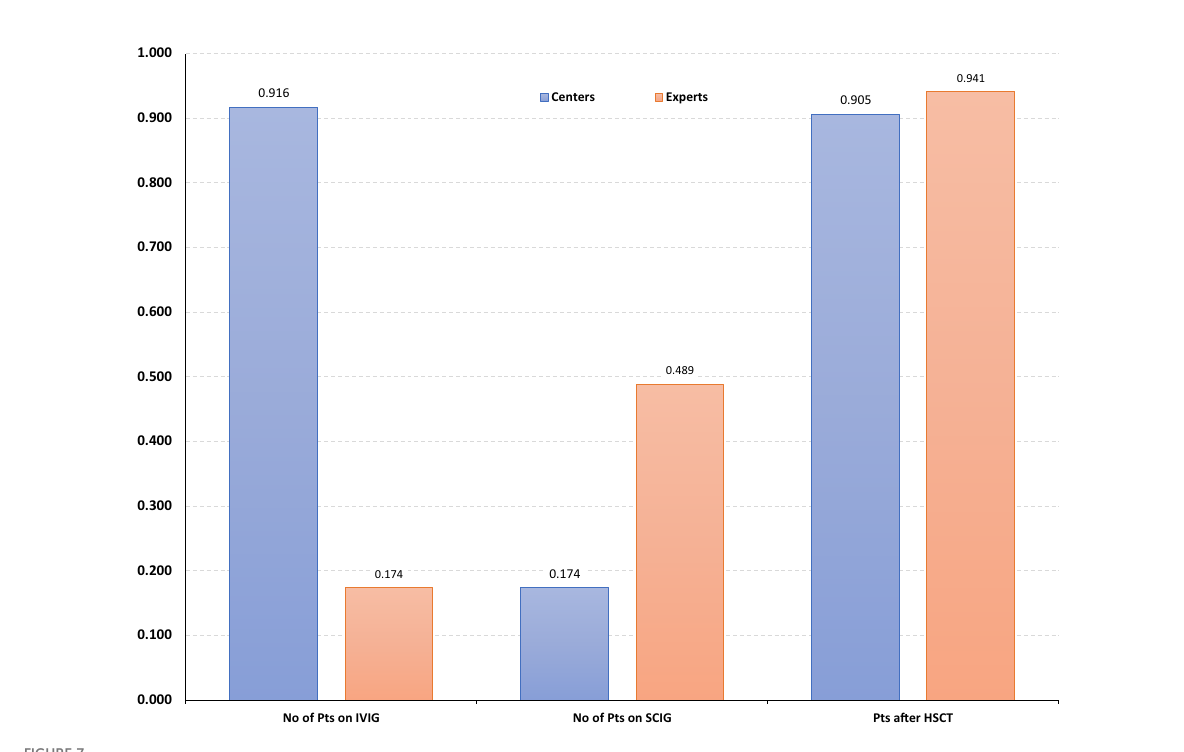
FIGURE 7 Correlations between the number of primary immunode fi ciency (PID) centers and PID experts with the replacement of intravenous immunoglobulin (IVIG) or subcutaneous Ig (SCIG) or the number of hematopoietic stem cell transplantation (HSCT) performed in various countries. Data show that higher number of centers and experts favored the treatment with IVIG and HSCT but not with